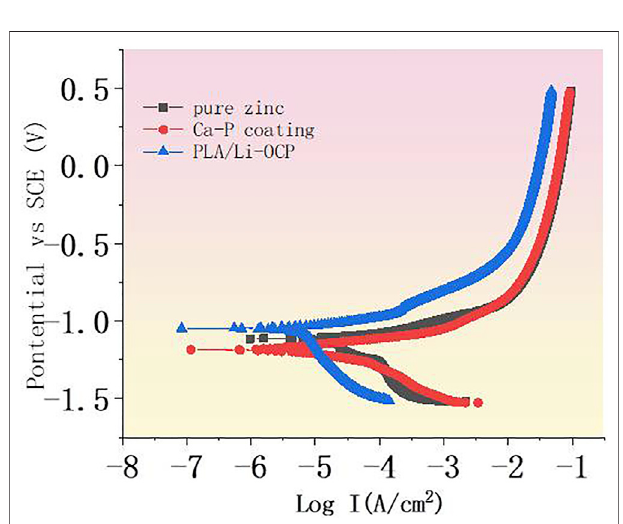
FIGURE 3 | The potentiodynamic polarization curves of coated zinc and pure zinc.